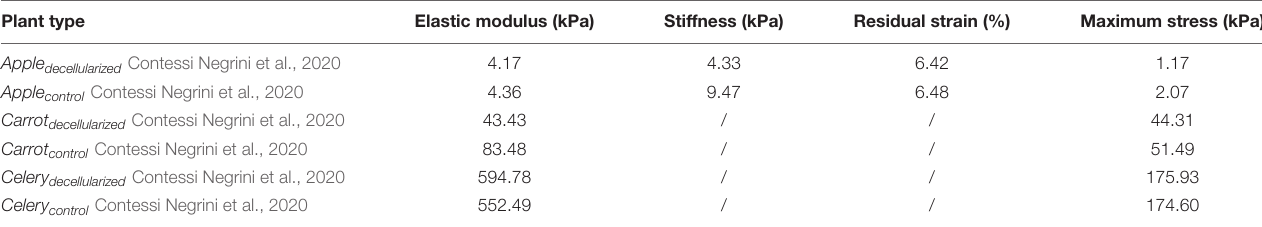
FIGURE 2 | Structure, pore size and similarities between human organs and plant scaffolds: Plant scaffolds are basically composed of cellulose, hemicellulose, lignin and pectin, and the porosity size and pore shape of different plant tissues are quite different. A scaffold with potential for organ regeneration can be obtained by selecting the plant tissue that is similar to the human organ tissue in physical properties for decellularization treatment. TABLE 2 | Mechanical properties of existing plant scaffolds.